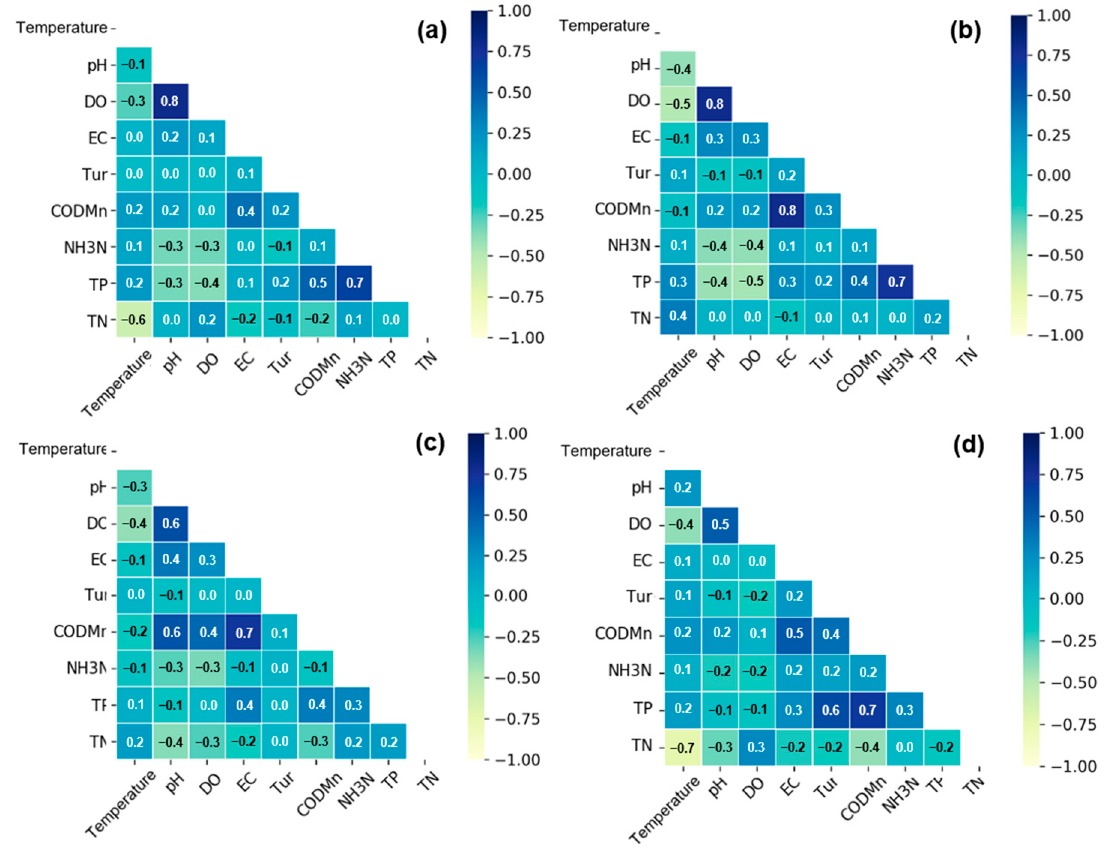
Figure 3. Seasonal correlations among water quality parameters. ( a ) spring; ( b ) summer; ( c ) autumn; ( d ) winter. DO, dissolved oxygen; EC, electrical conductivity, Tur, turbidity; COD Mn , permanganate index; NH 3 N, ammonia nitrogen; TP, total phosphorus; TN, total